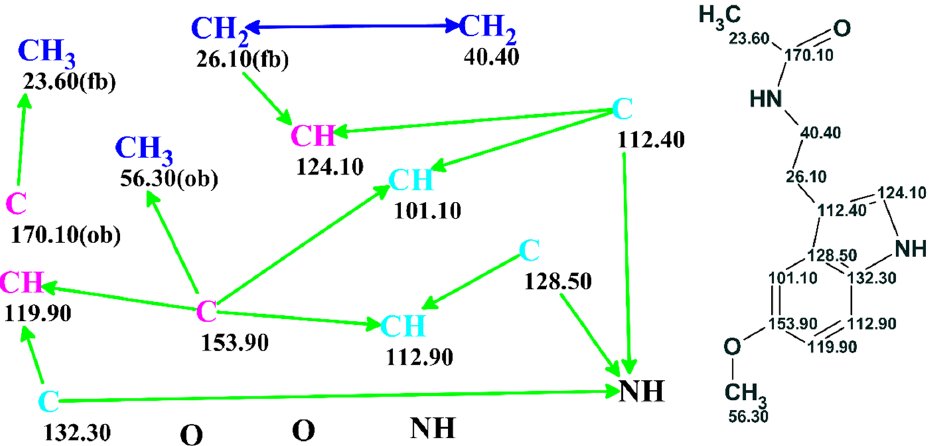
Figure 3. MCD created for the structure shown on the right using data obtained from both HMBC and COSY spectra. Carbon atom hybridization is marked in color as: sp 3 —blue, sp 2 —violet, not sp ( sp 3 or sp 2 )—light blue. HMBC connectivities are indicated by green arrows and COSY connectivities by blue arrows. The label “ fb ” near a carbon atom means that bonding with a heteroatom is forbidden, while the label “ ob ” means that bonding of that given atom to at least one heteroatom is obligatory. The MCD was first introduced ACD/SE_v2 and remains important to present day as a visual cue of NMR correlations.